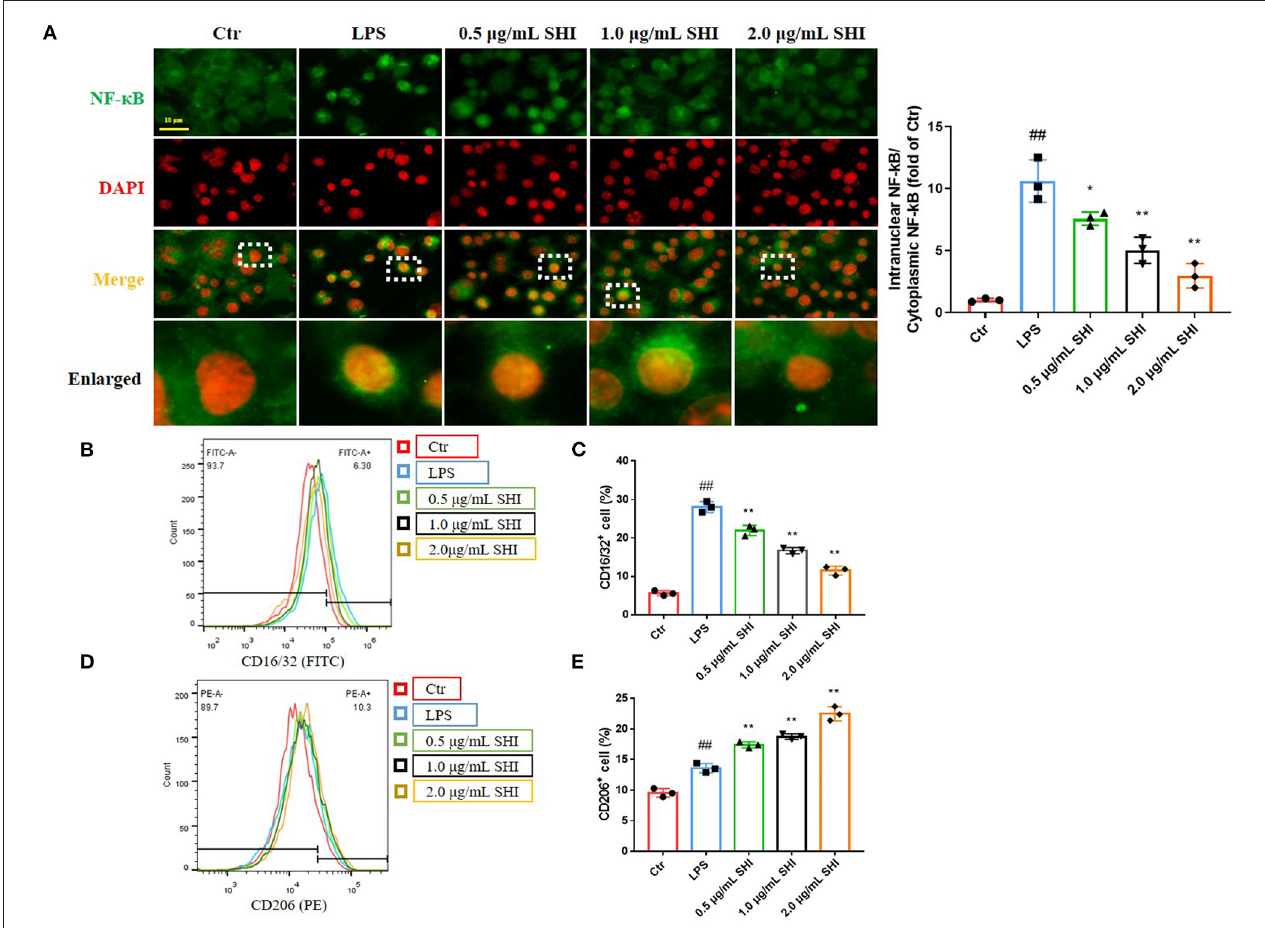
FIGURE 4 | The effect of Shionone on macrophage inflammation. (A) Representative images of NF- κ B in nucleus and cytoplasm detected by immunofluorescence ( n = 3). (B,C) CD16/32 flow assay for M1 macrophages and the proportion of M1 macrophages in each group ( n = 3). (D,E) CD206 flow assay for M2 macrophages and the proportion of M2 macrophages in each group ( n = 3). Control group was used as a negative control and LPS group as a positive control. Results are expressed as ± SD for independent experiments, ## p < 0.01 vs. LPS group, and * p < 0.05 vs. Control group, ** p < 0.01 vs. LPS group, one ANOVA followed by Tukey’s post-hoc